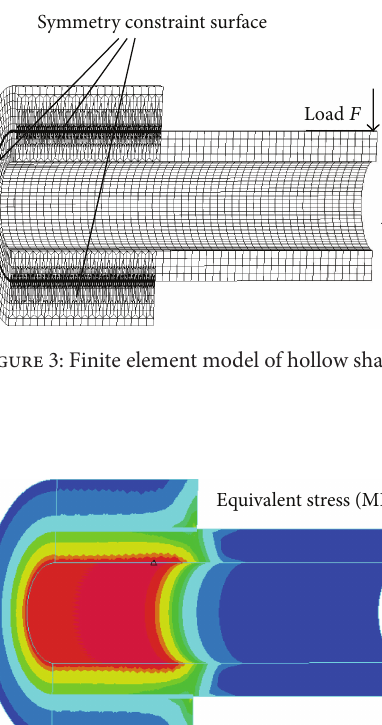
Figure 4: Equivalent stress of the assembly body.